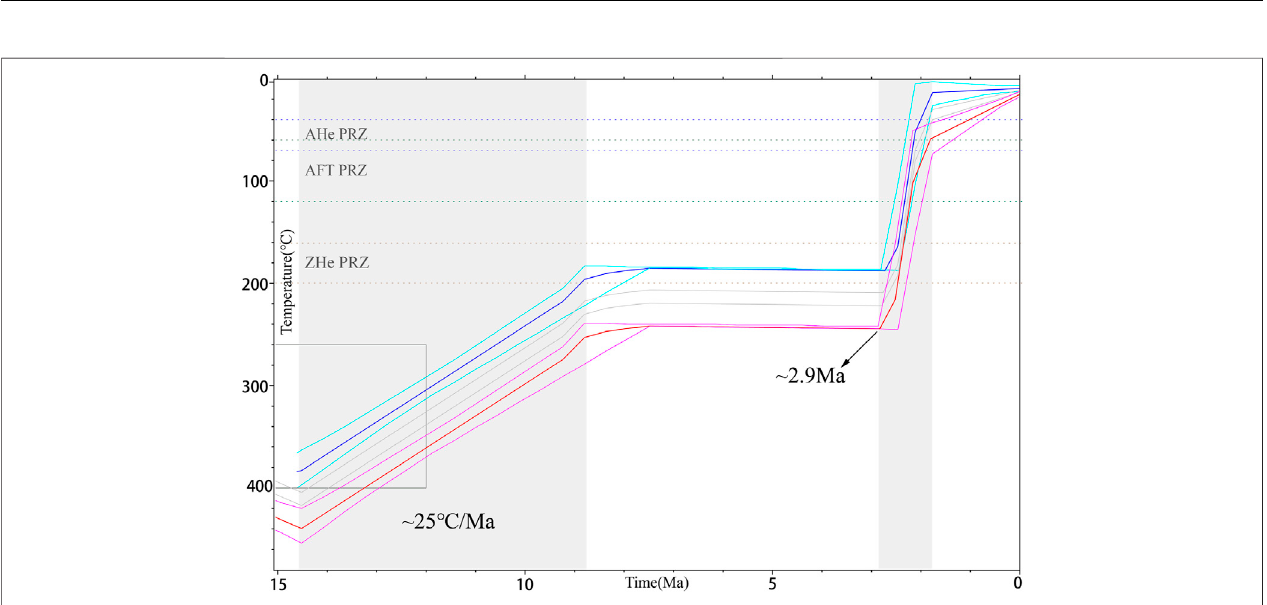
FIGURE 7 | Thermal modelling of the GLG transect using QTQt (Gallagher, 2012). The grey box indicates the initial constraint. For the uppermost thermal history, the thin blue lines depict 95% con fi dence intervals, re fl ecting the uncertainty in the inferred thermal history alone. For the lowermost thermal history, the thin red lines show 95% con fi dence intervals, re fl ecting combined uncertainties in the inferred thermal history and temperature offset. The provided AHe ages are uncorrected for the comparison of observed and predicted data.